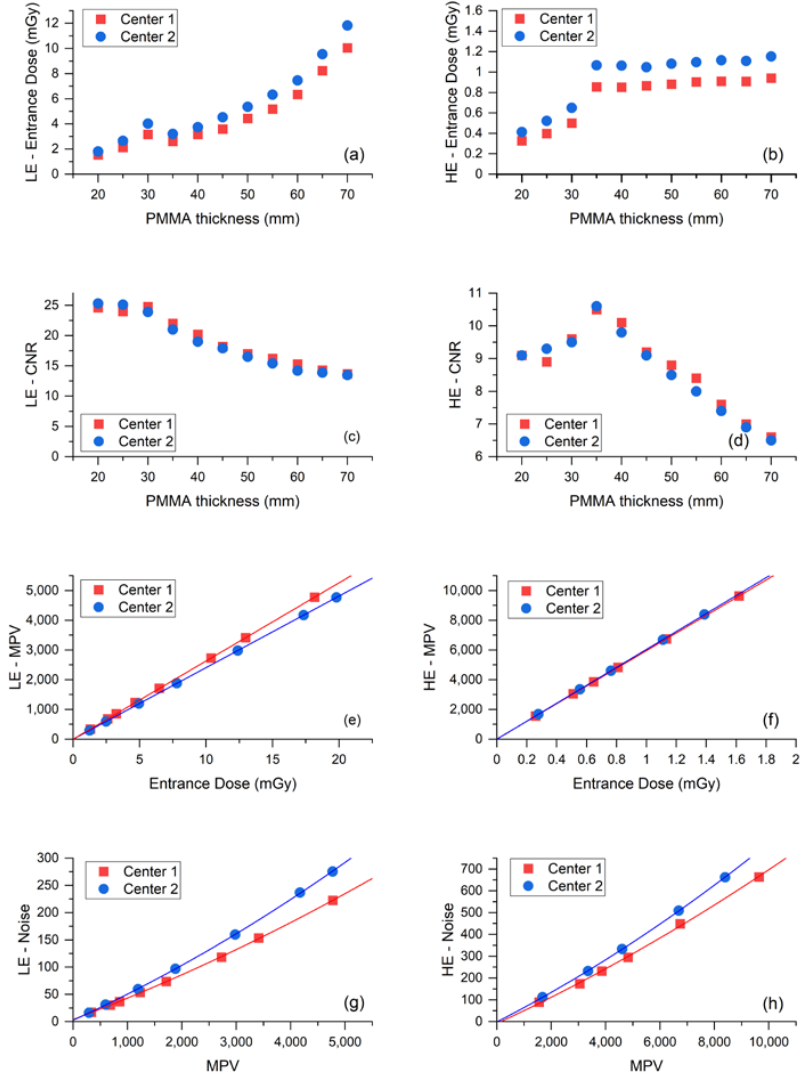
Figure 2. ( a ) ED used by the AEC to acquire the LE-images of PMMA phantoms as a function of phantom thickness. ( b ) ED used by the AEC to acquire the HE-images of PMMA phantoms as a function of phantom thickness. ( c ) Contrast-to-noise ratio (CNR) measured from the LE-images as a function of PMMA thickness. ( d ) CNR measured from the HE-images as a function of PMMA thickness. ( e ) Response function (MPV vs. ED) for LE-image acquisition. ( f ) Response function for HE-image acquisition. ( g ) Noise evaluation (SD 2 vs. MPV) for LE-image acquisition. ( h ) Noise evaluation for HE-image acquisition.